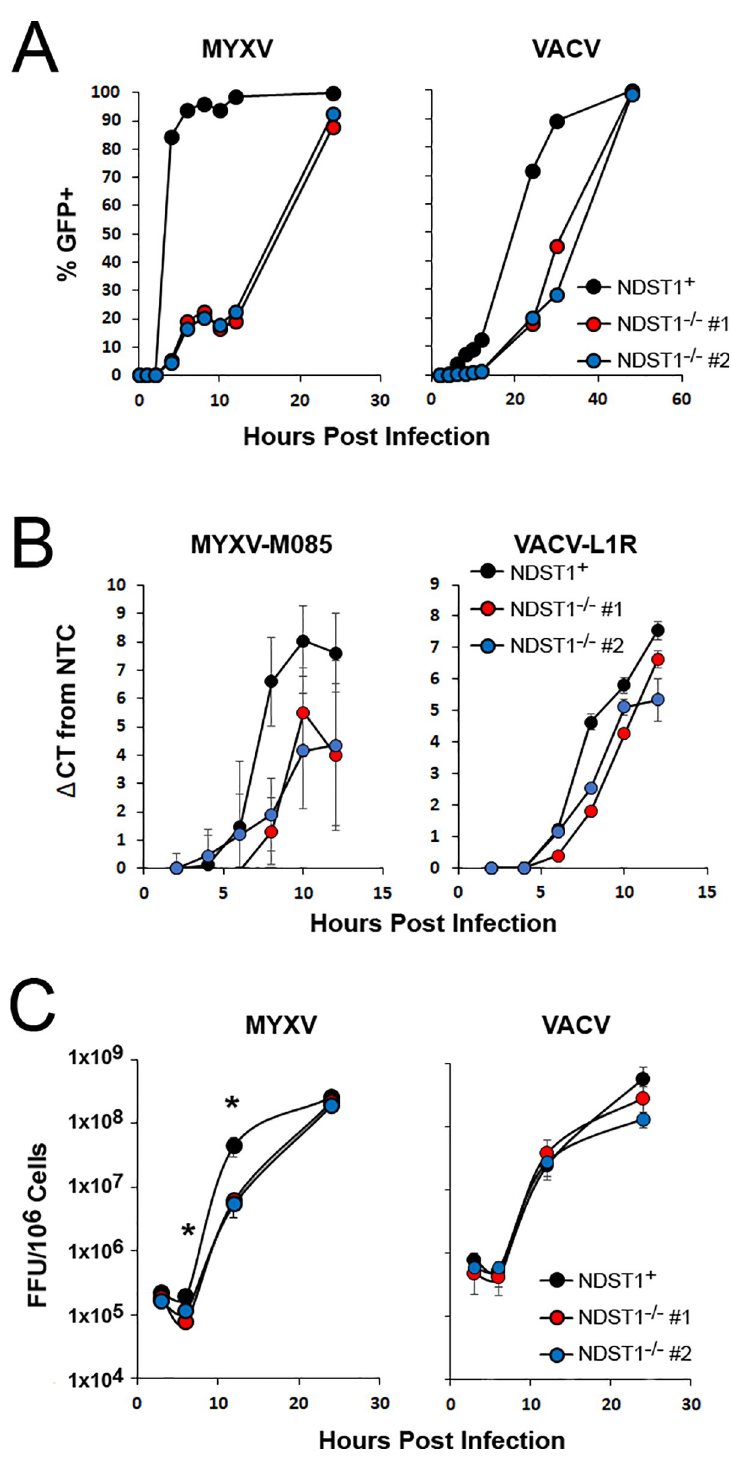
Fig 4. Loss of sulfation delays intracellular poxviral replication. (A) Kinetic analysis of GFP expression after initial infection of NDST1 + or deficient cells. NDST1 + or deficient B16/F10 cells were infected with either MYXV or VACV and GFP expression measured every two hours using flow cytometry. Data presented is representative of two independent experiments. (B) Abundance of MYXV or VACV genomes measured using qPCR. Data presented is representative of three independent experiments for both viruses each analyzed in triplicate and is presented as the change in cycle threshold value ( Δ CT) from 2 hour baseline. (C) Production of new infection viral progeny in either